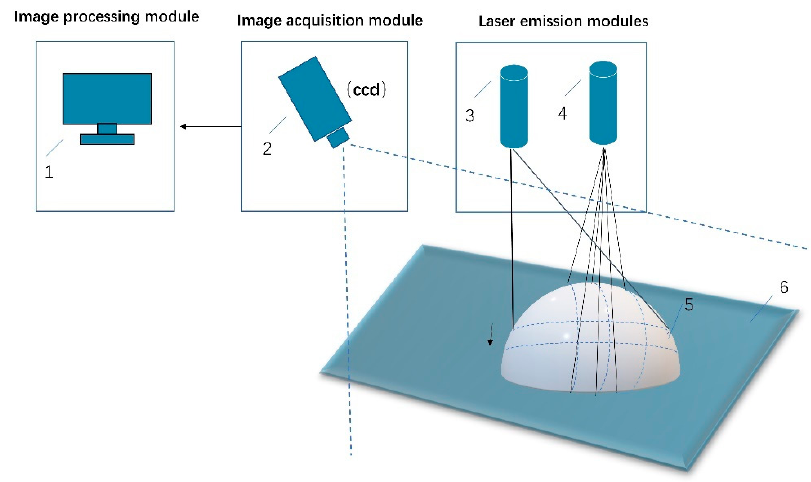
Figure 1. The diagram of the measurement system. (1) Computer, (2) Camera, (3) Single-line laser, (4) Three-line laser, (5) Object, (6) Experiment platform.